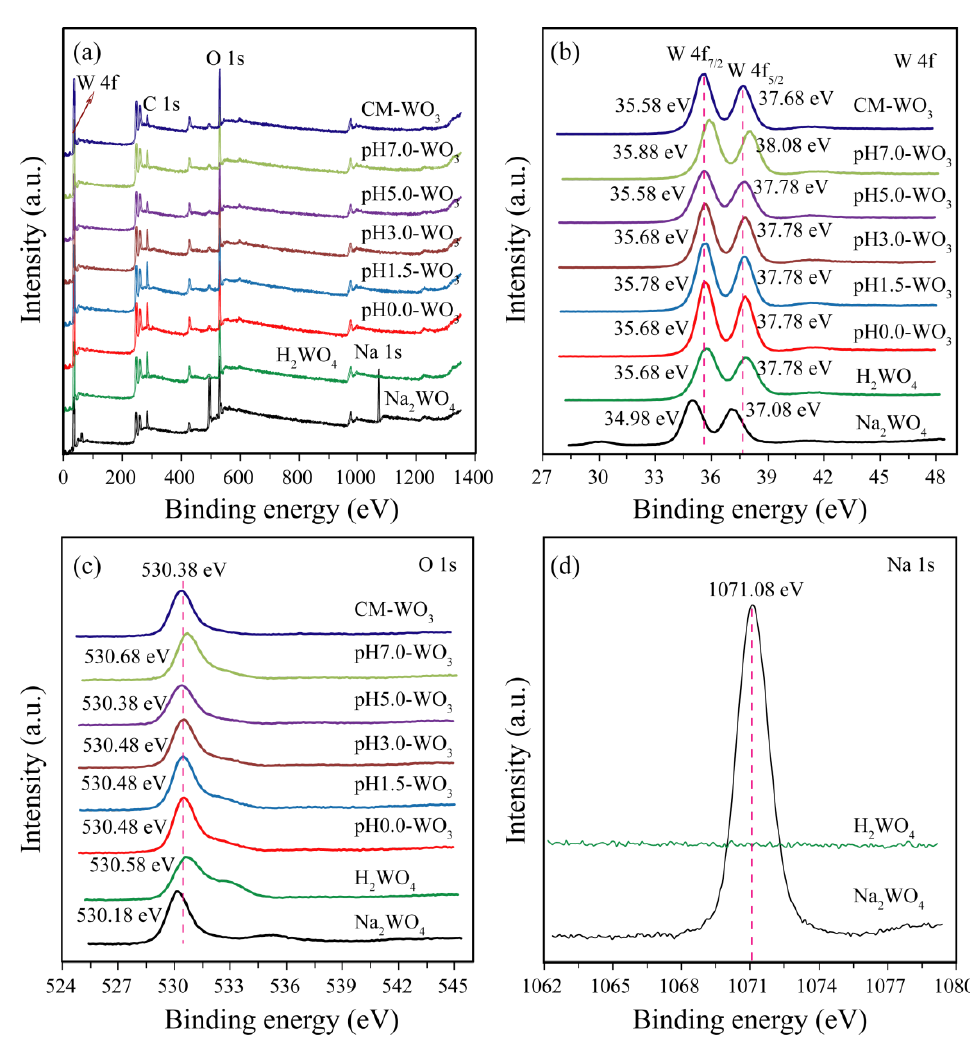
Figure 7. XPS spectra of Na 2 WO 4 , H 2 WO 4 , as-prepared pH x -WO 3, and the CM-WO 3 samples: ( a ) survey scan; high-resolution ( b ) W 4f, ( c ) O 1s, and ( d ) Na 1s spectrum. ( a ) survey scan; high-resolution ( b ) W 4f, ( c ) O 1s, and ( d ) Na 1s